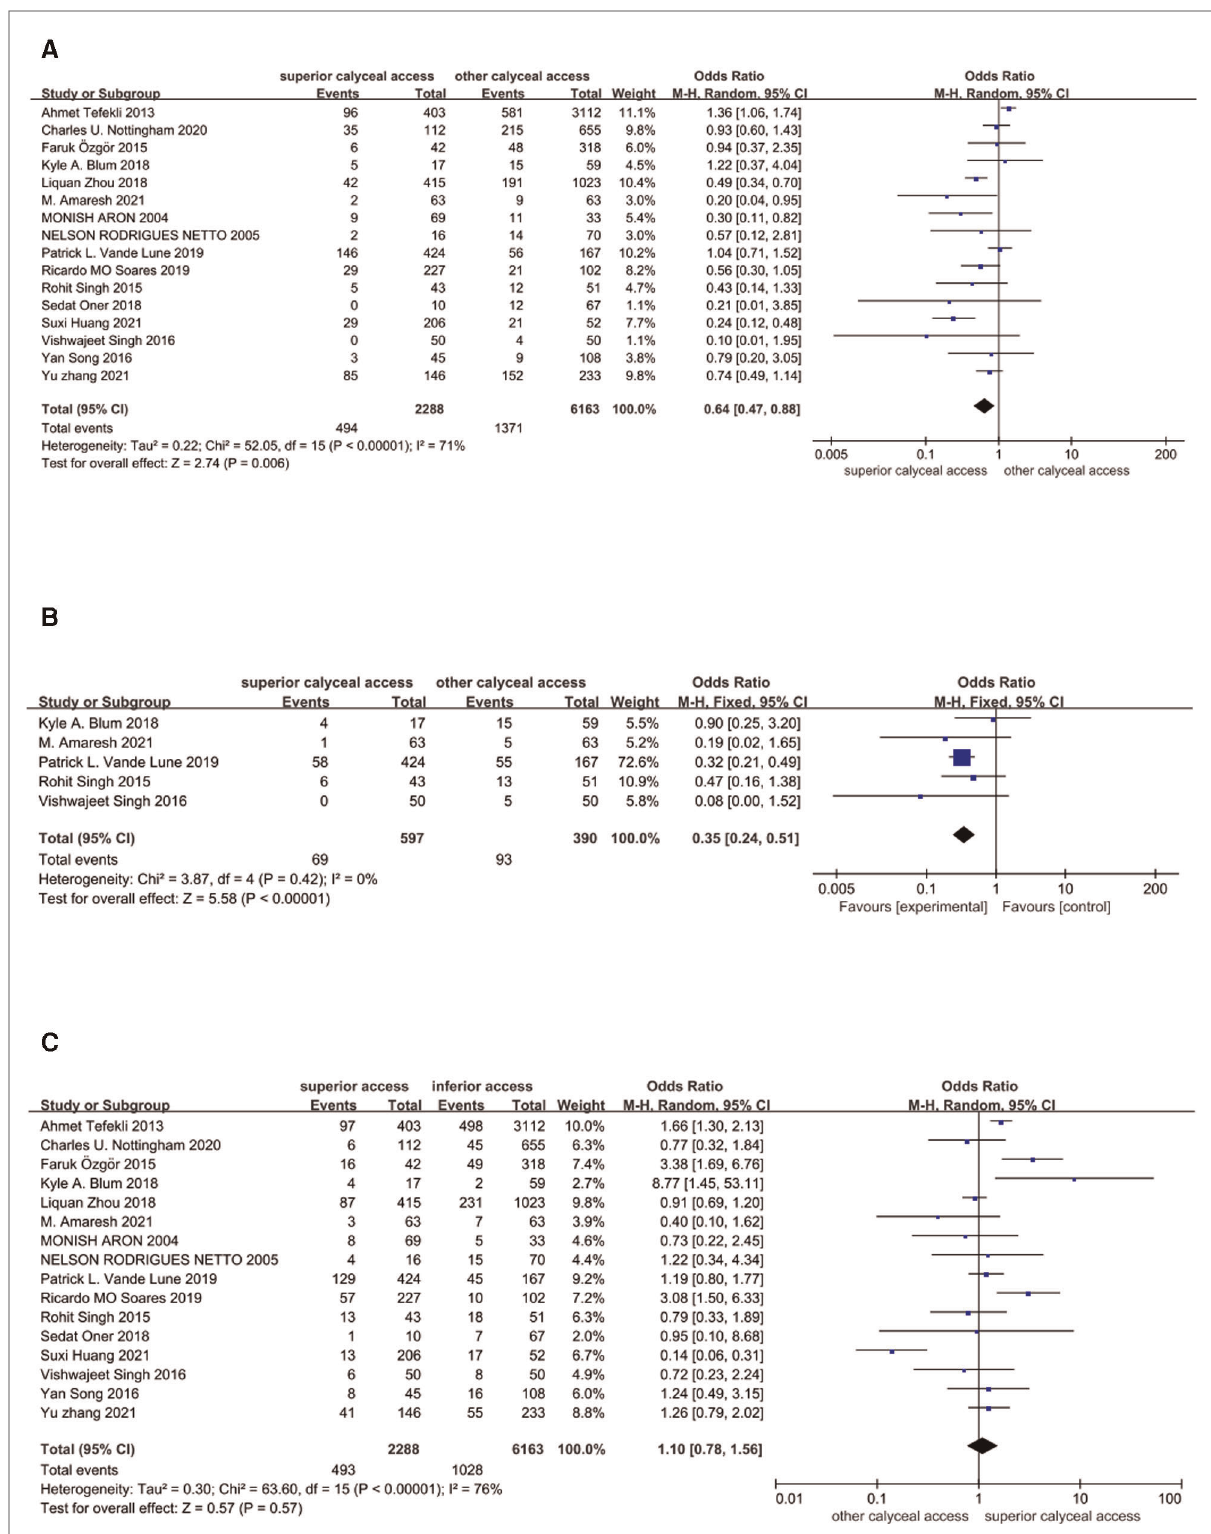
FIGURE 2 Forest plots of meta-analysis. ( A ) Stone clearance comparison between superior calyceal access and other calyceal access. ( B ) Additional puncture rate comparison between superior calyceal access and other calyceal access. ( C ) Complication comparison between superior calyceal access and other calyceal